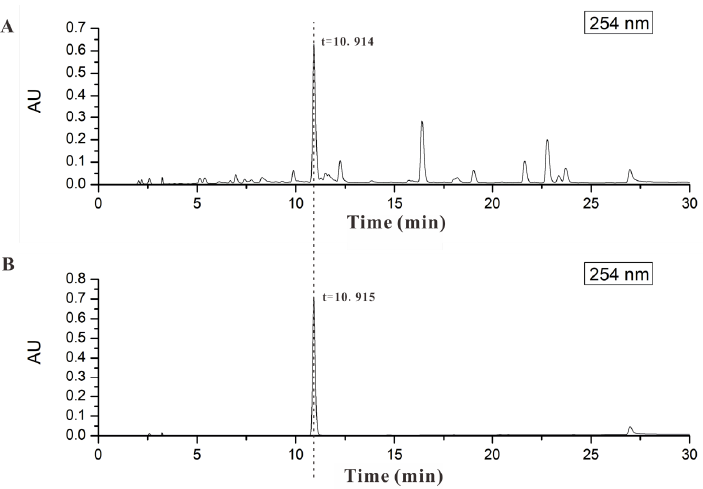
Figure 1. AND was the major component in AP-EtOAc. ( A ) HPLC analysis of AP-EtOAc shown at 254 nm. ( B ) HPLC analysis of AND shown at 254